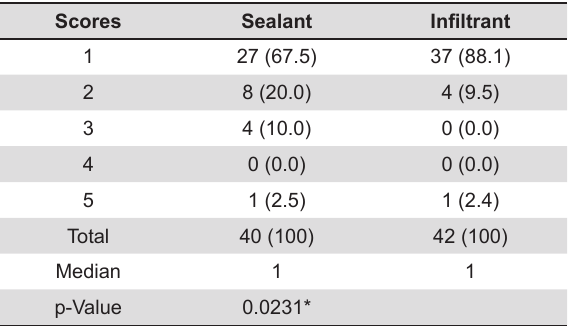
Table 2- Distribution of caries detection using radiographic analysis after 3 years